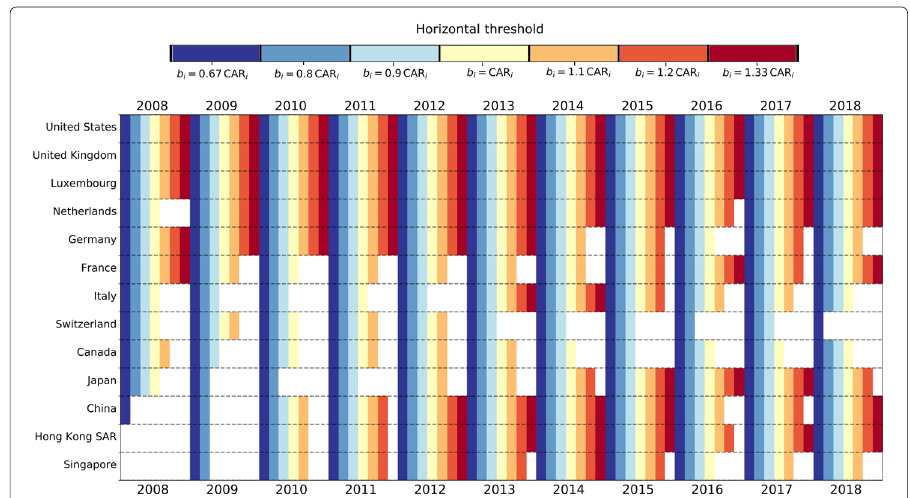
Fig. 7 Buffer size and systemic importance of countries in our multilayer threshold model. The colored entries signify that a country i is systemically important for a given year and horizontal threshold, and a white entry signifies that a country is not systemically important. The blue entries correspond to a country being systemically important for a horizontal threshold that is smaller than the baseline value b i = CAR i , and the red (and orange) entries indicate systemically important countries for a horizontal threshold that is larger than the baseline. For this plot, we select all countries that are systemically important in at least four years when we use the baseline horizontal